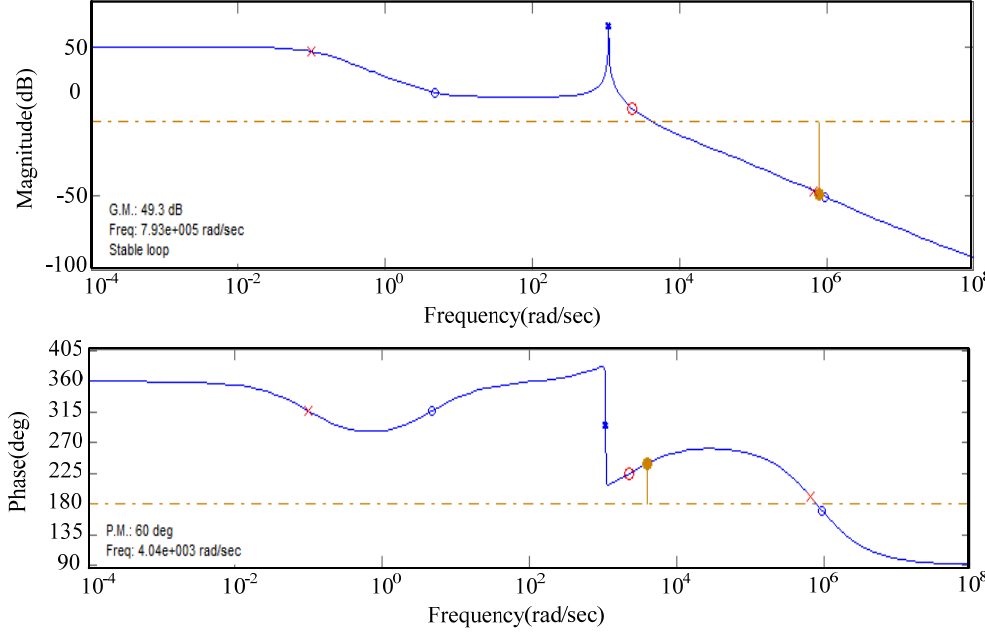
Figure 18. Bode plots of the proposed converter under the closed loop